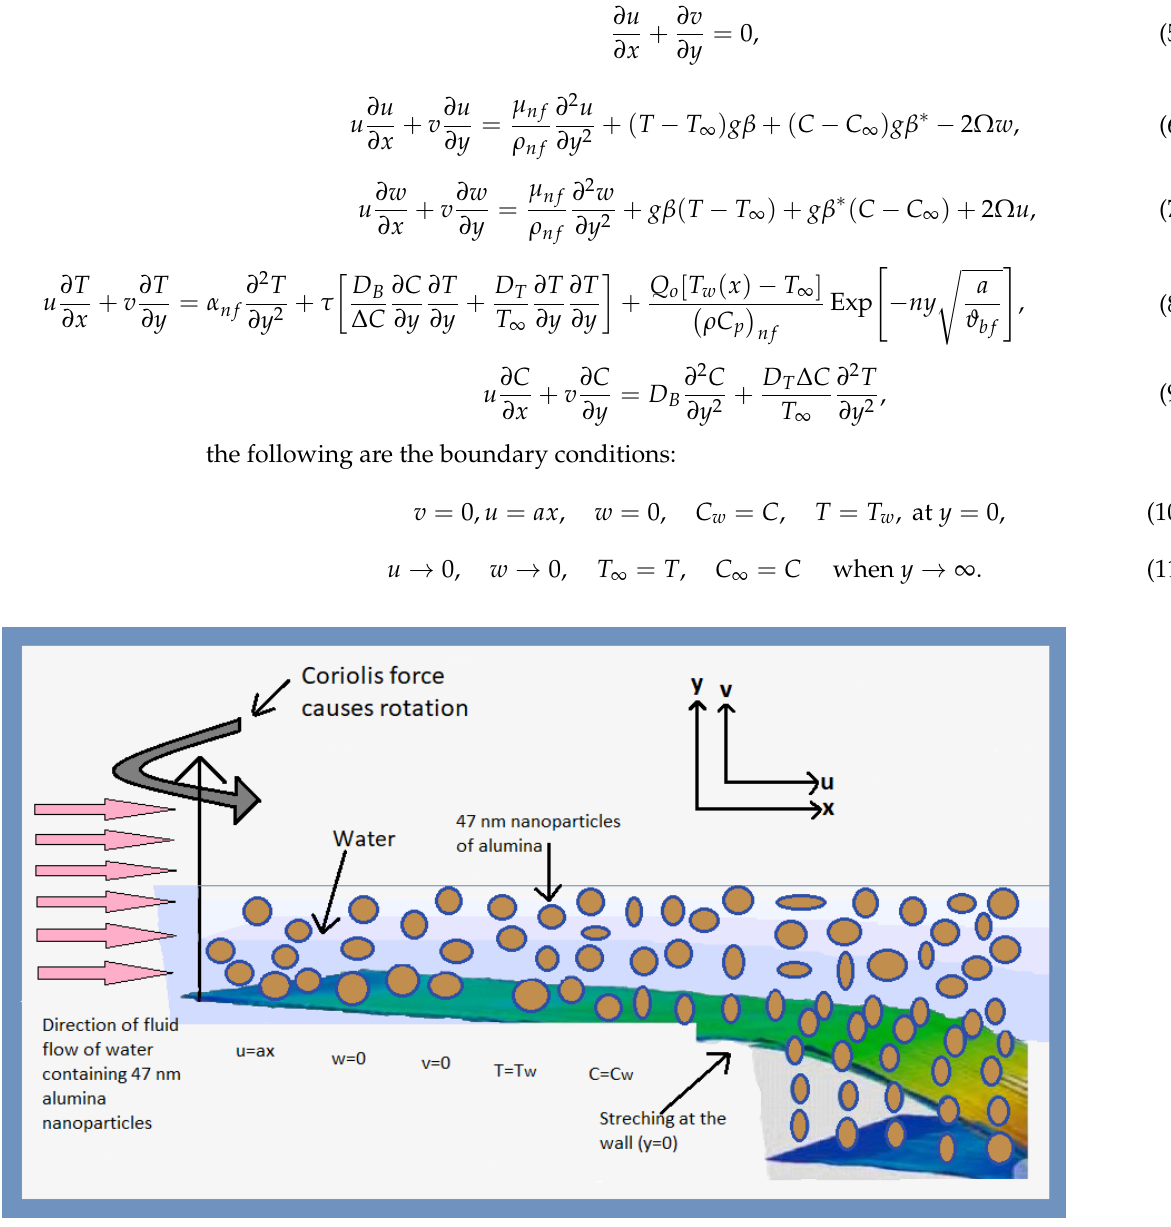
Figure 1. Graphical representation of the water having 47 nm nanoparticles of alumina of the transport